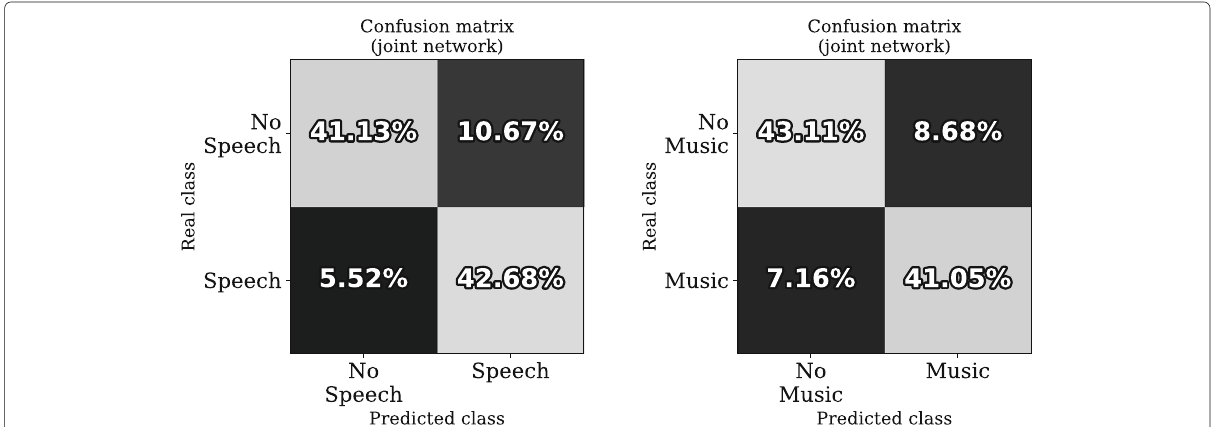
Fig. 10 Two-class confusion matrices of the best network setting for speech and music event detection (C2-LSTM model with L = 6 and N = 256). The percentages indicate the total amount of test segments in each possible real class-predicted class